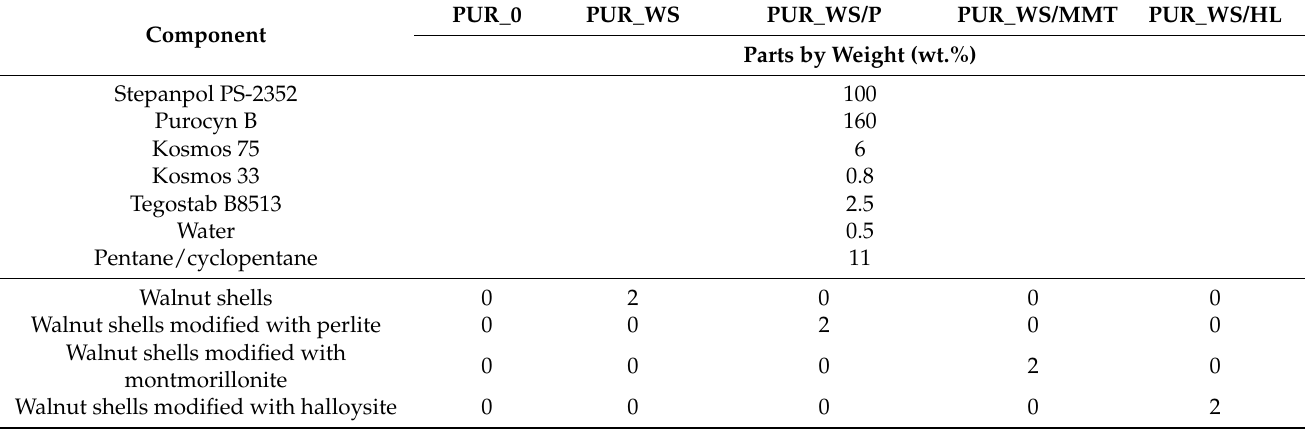
Table 5. The formulations of PUR composites reinforced with walnut shell fillers.